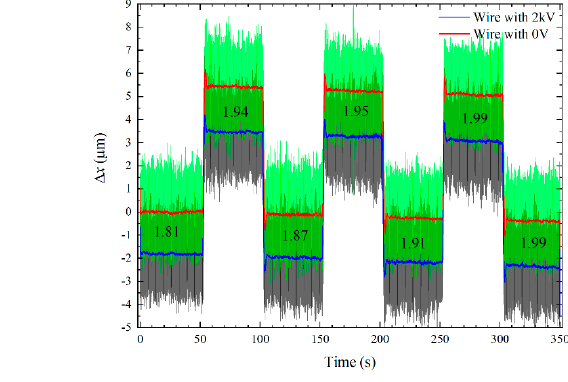
Figure 20. Arm displacement as a function of wire voltage.